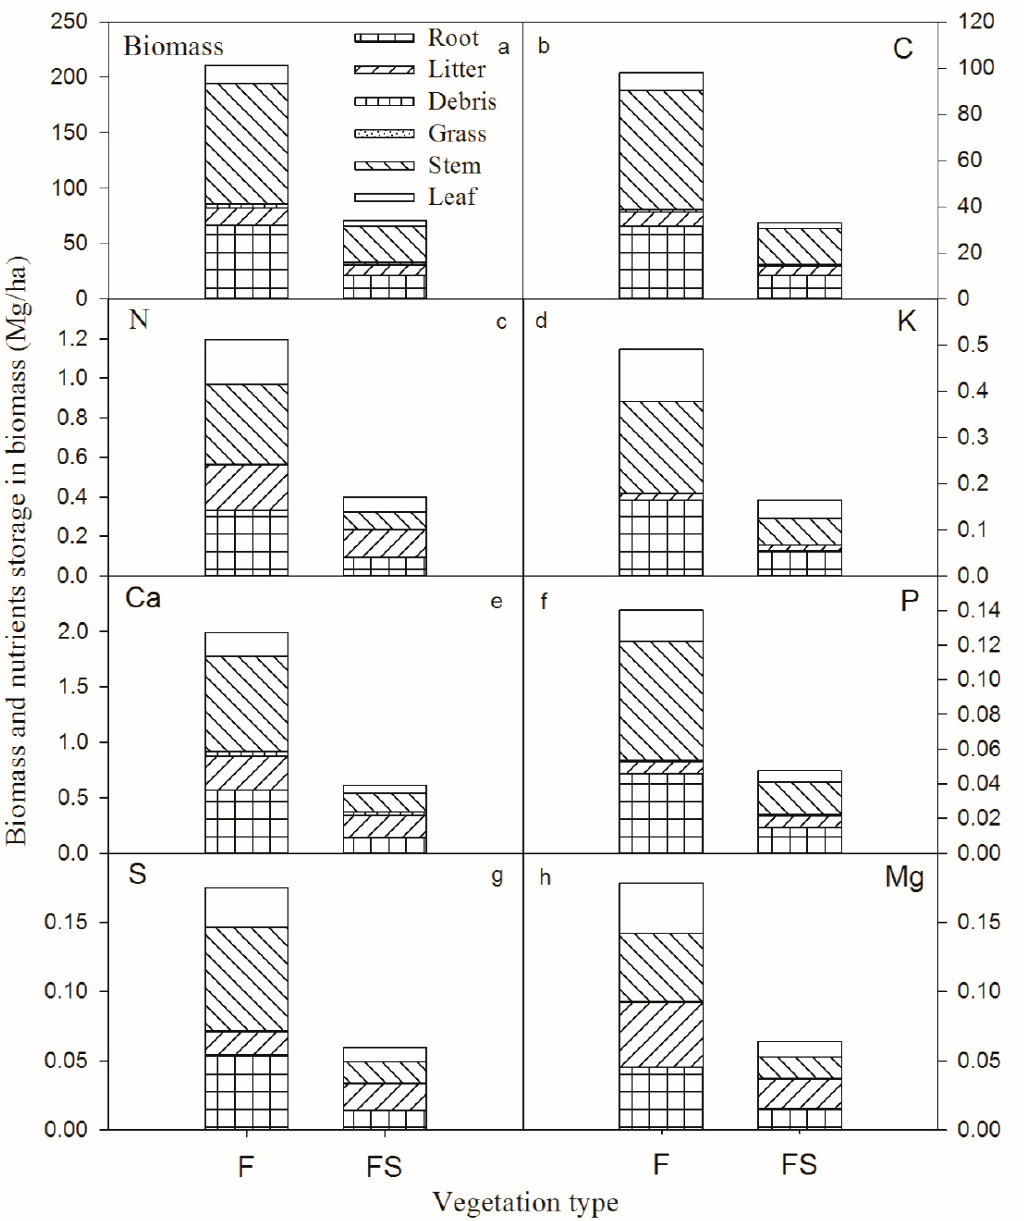
Figure 5. Biomass and nutrient storage in the biomass of two different vegetation types in southwestern